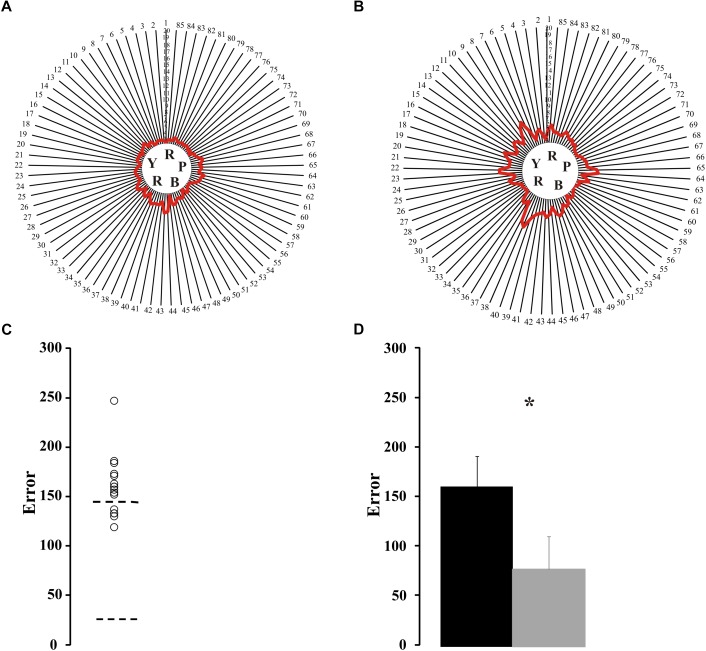
Results of Farnsworth-Munsell 100 hue arrangement test. (A,B) Maps of results for the FM100 test from a control subject and an ex-alcoholic. Red lines represent the averaged error for the four trials of each subject. (C) Scatter plot for FM100 score estimated from ex-alcoholic subjects (circles). Dotted lines are tolerance interval for the control group. (D) Comparison of mean values for the FM100 scores estimated from the control group (gray bar) and ex-alcoholic group (black bar). Error bars represent the standard deviation of the mean. ∗p < 0.05.